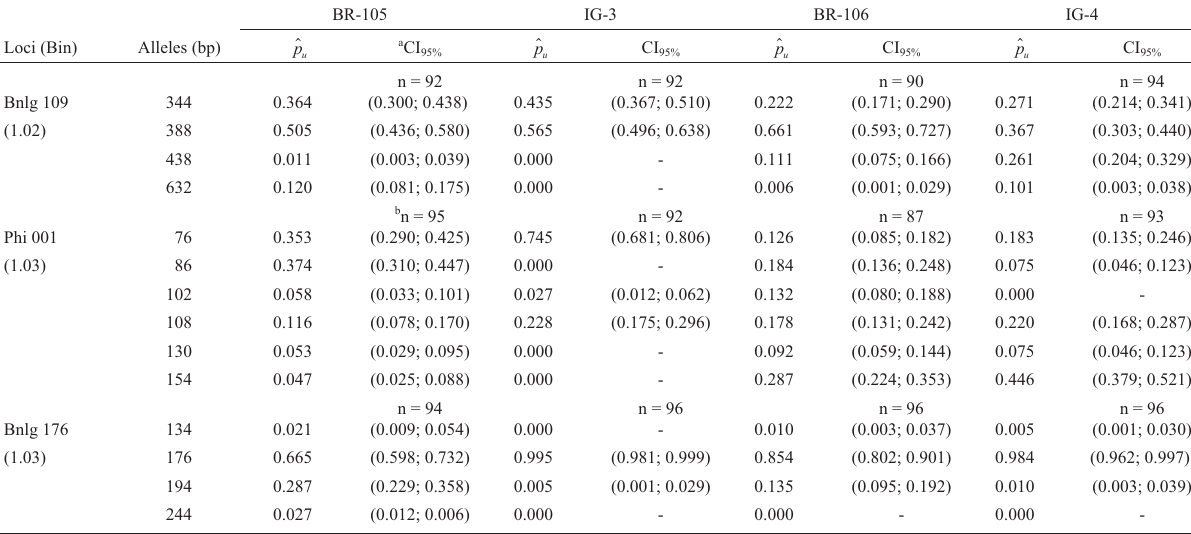
Table 1 - Allele frequency distribution ( $ p u ) in two maize populations (BR-105 and BR-106) and their synthetics (IG-3 and IG-4) according to the microsatellite locus. BR-105 Loci (Bin) Alleles